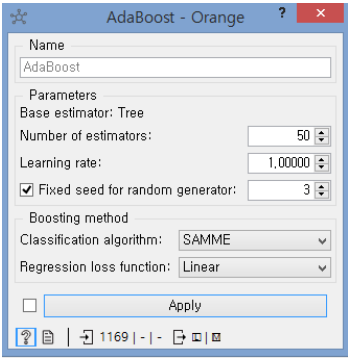
Figure 11. Parameters of the proposed AdaBoost model [79].